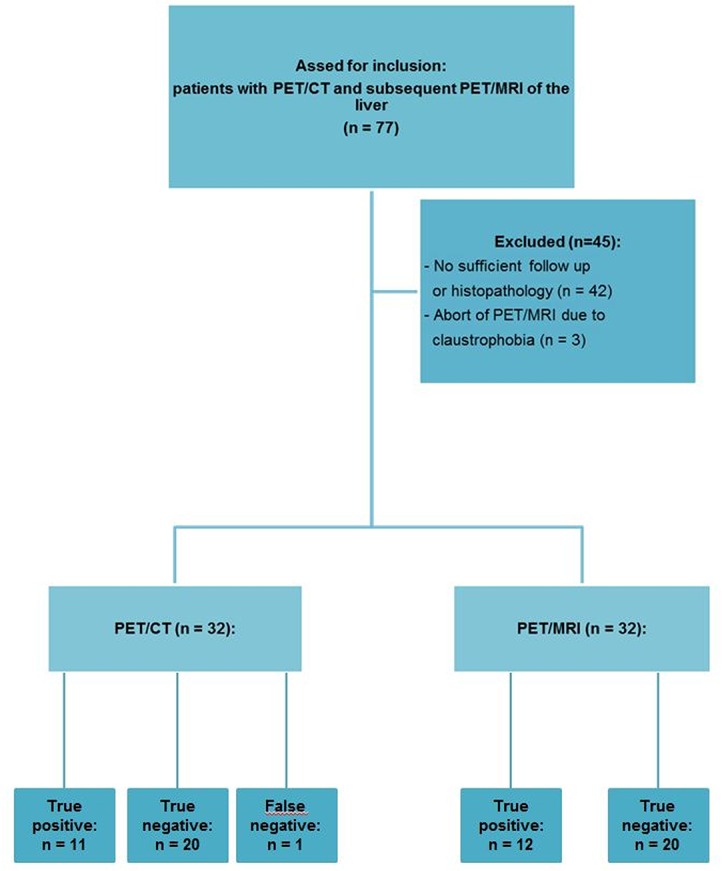
Study flow diagram.